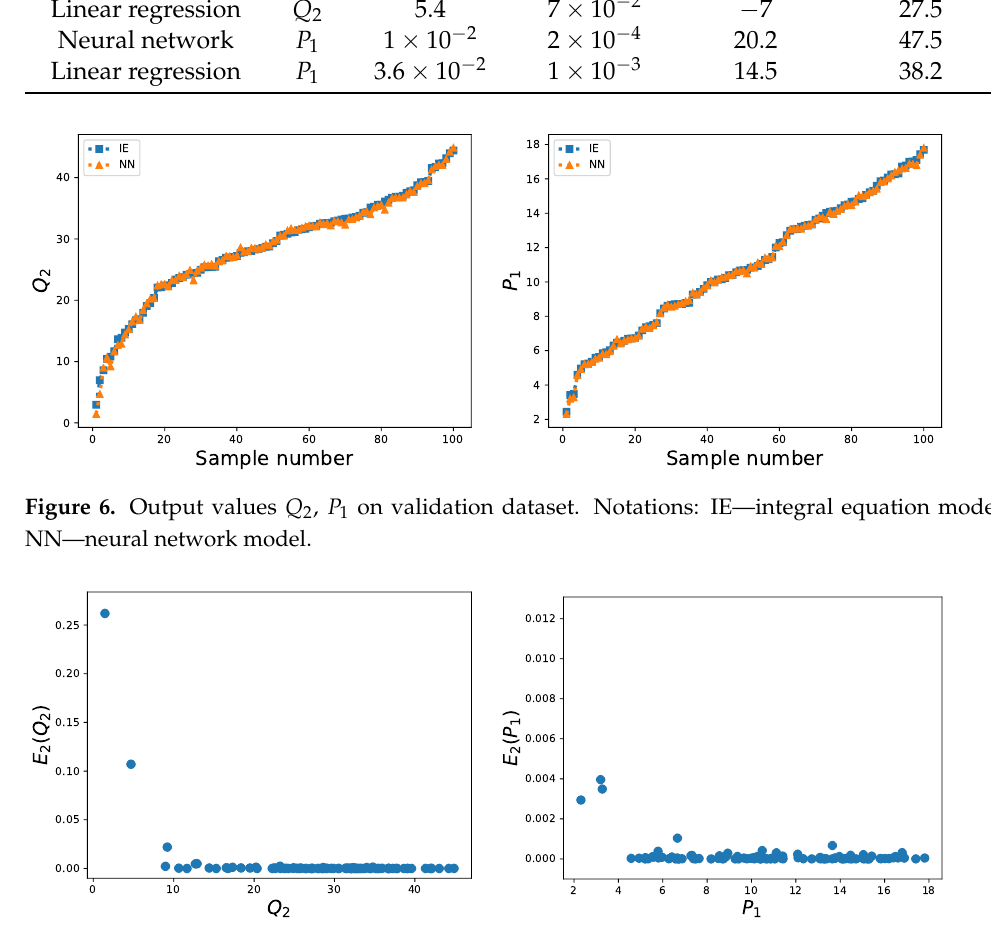
Figure 7. Estimated prediction error for Q 2 , P 1 on validation dataset. Notations: IE—integral equation model, NN—neural network